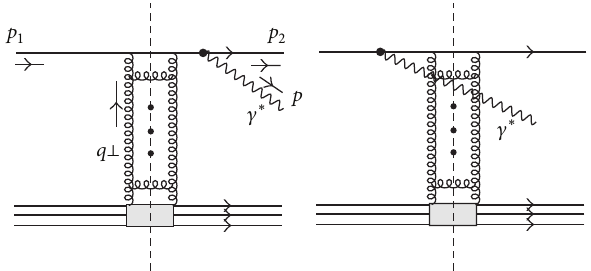
Figure 6: Schematic illustration of the typical contributions and kinematics of the diffractive Drell-Yan process in the quark-target